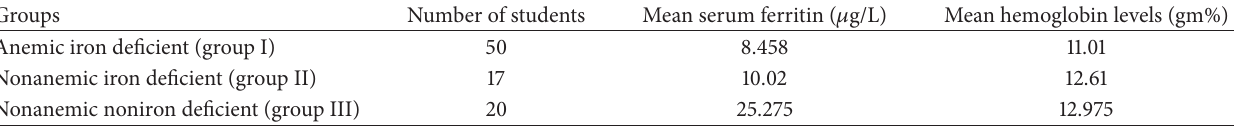
Table 1: Number of students in different groups, mean serum ferritin, and hemoglobin levels.